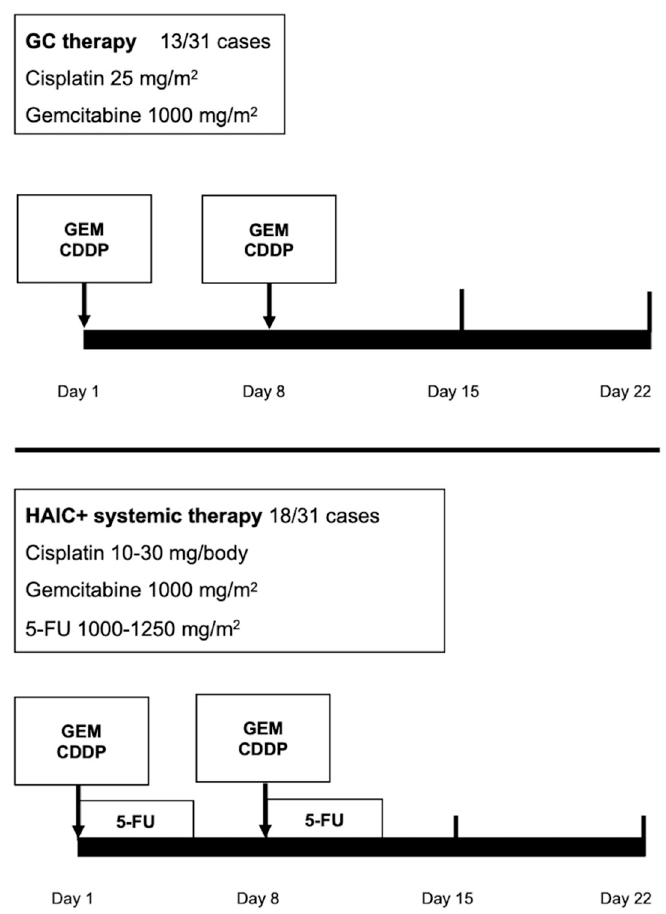
Figure 2. Treatment regimens for intrahepatic cholangiocarcinoma (ICC).